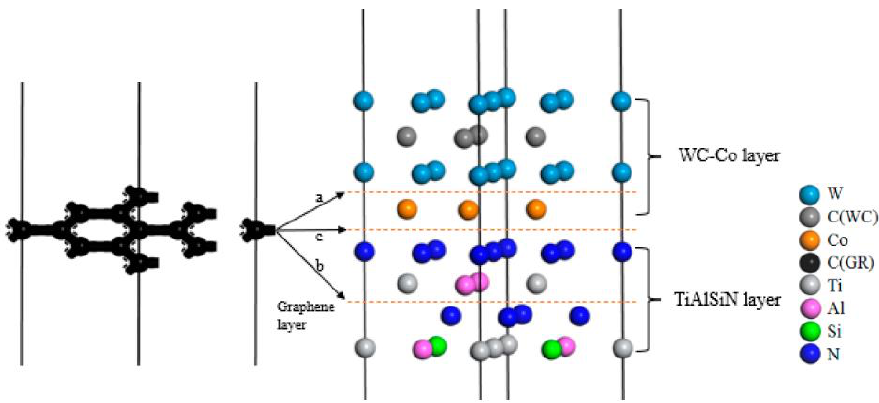
Figure 6. The construction process of the graphene-doped TiAlSiN/WC-Co interface model: a — represents matrix interface doped with graphene, b — represents coating interface doped with graphene, and c — represents coating/matrix interface doped with graphene.